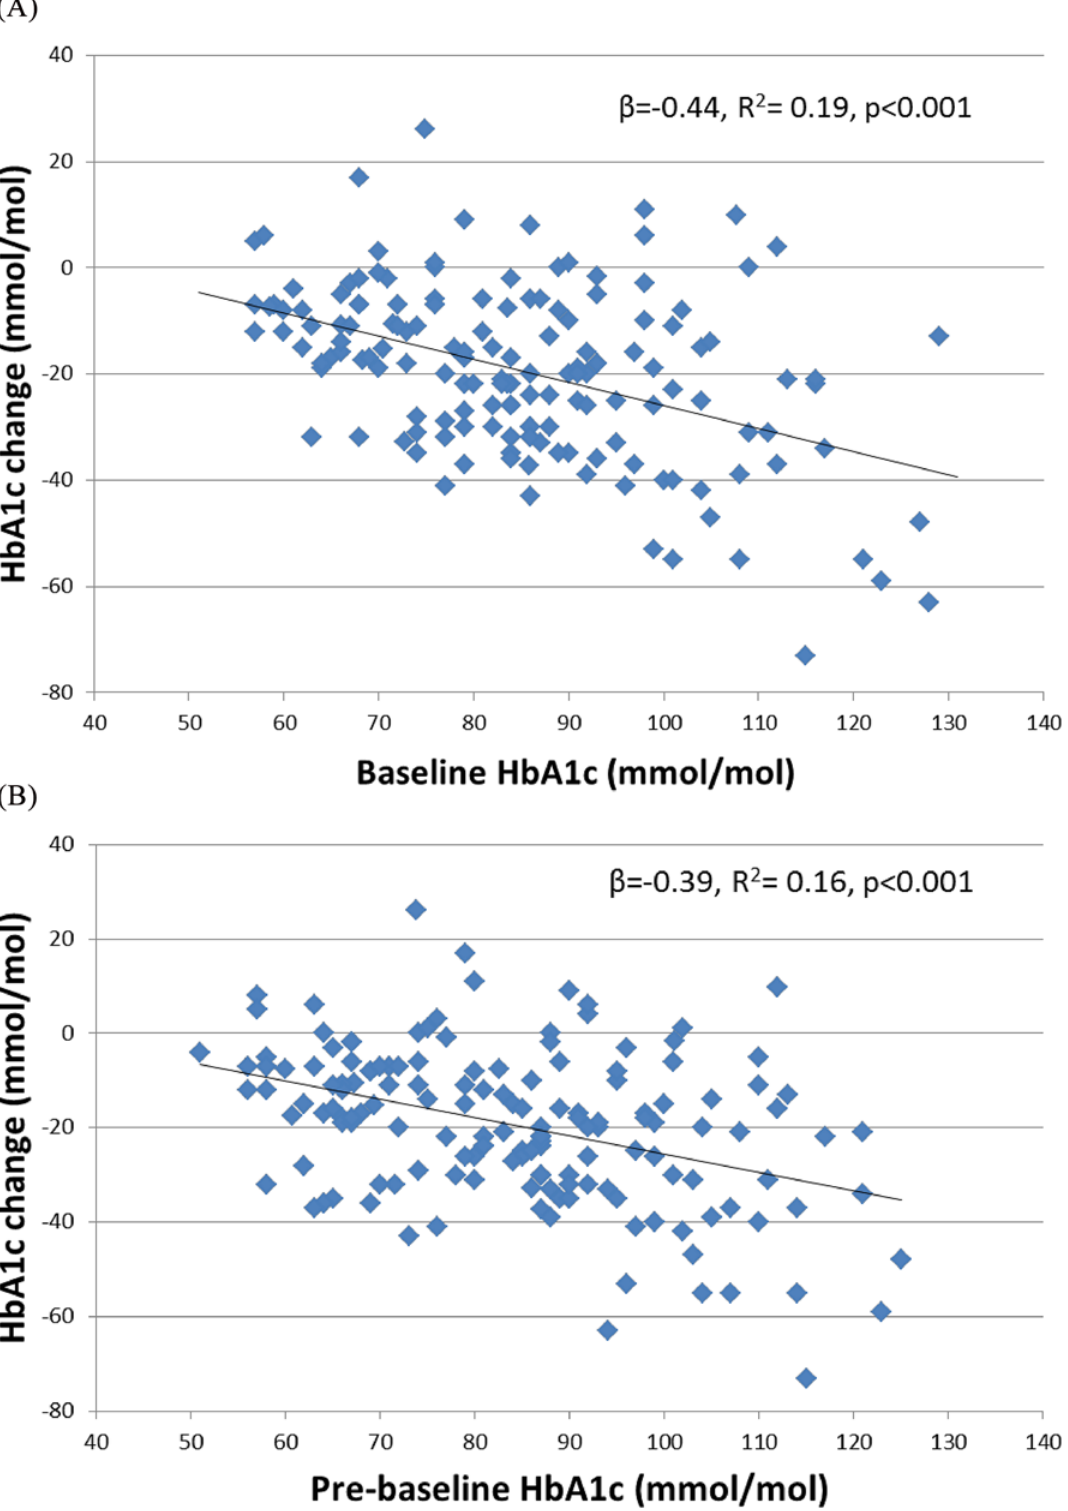
Fig 1. The association between post treatment HbA1c change and A: baseline HbA1c and B: Pre-baseline HbA1c (GLP-1RA cohort).